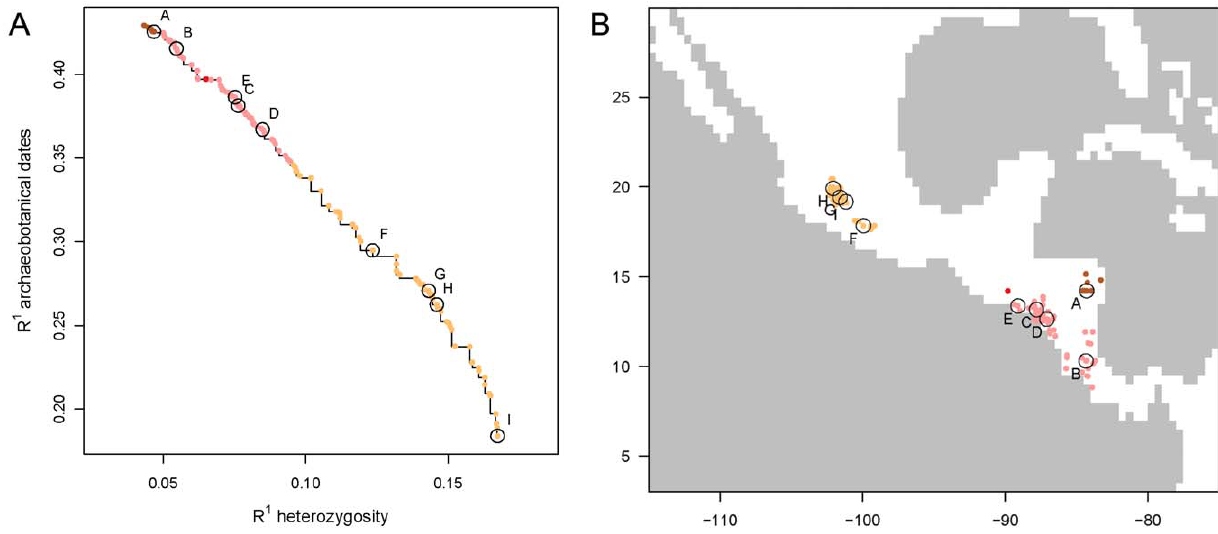
Figure 2. Pareto solutions obtained by fitting the landscape model with archaeobotanical and genetic data. A. Model fits at the Pareto front, with selected solutions labeled from A to I. B. Inferred locations of crop origin, with colors and labels corresponding to those of Figure 2A.